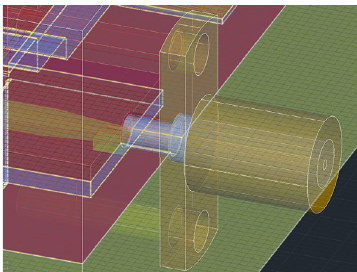
Figure 5. Mount design for panel mounted SMA connectors. Pressure-assisted contact of the center pint with transmission line metal is ensured as well as the ground tabs so as not to require neither soldering nor gluing. This is ensured by proper locating of the connector and using a set of screws,